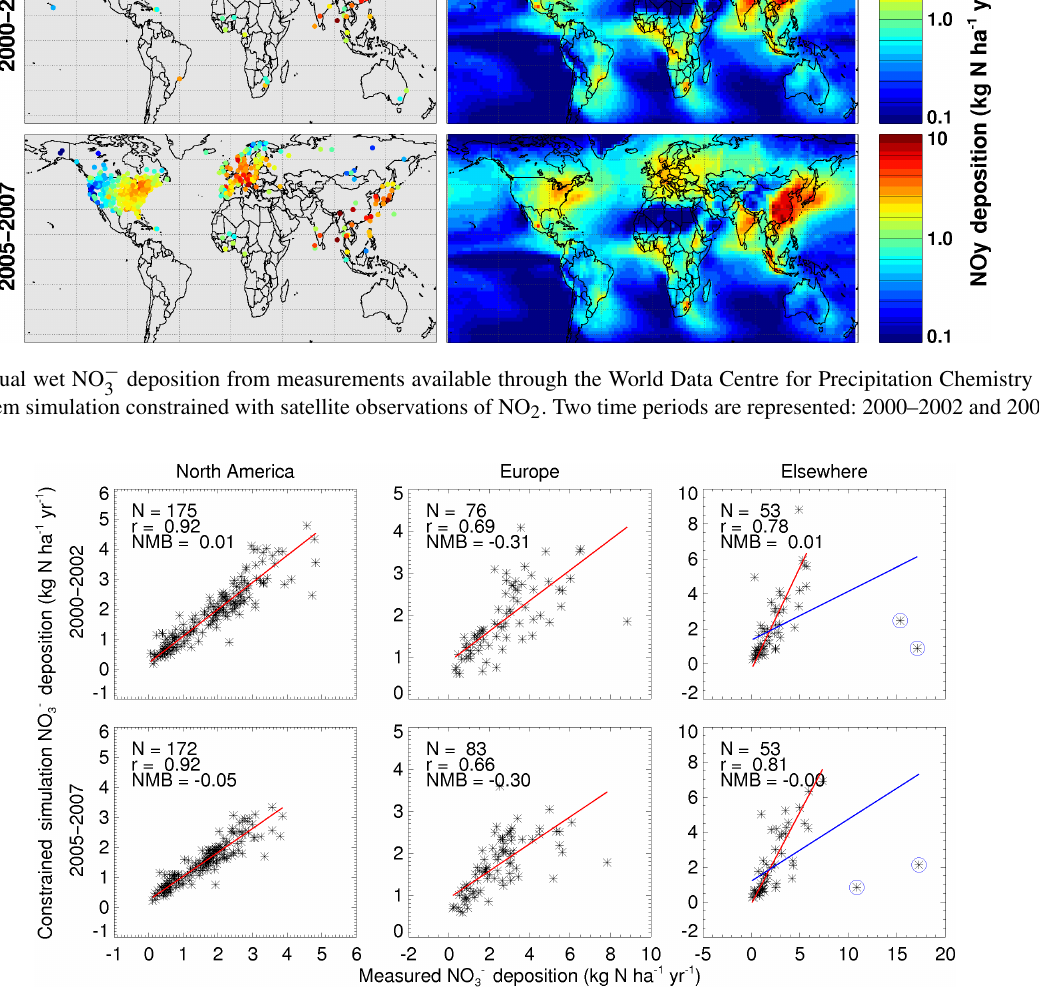
Figure 3. Scatter plot of the satellite-constrained simulated wet NO − deposition vs. measurements available through the World Data Centre 3 for Precipitation Chemistry for specific subsets of the data. The red lines show the result of a reduced major axis linear regression. In the right column, the blue line shows the fit across all data and the red line shows the fit excluding the two circled data points that are discussed in the text (reported statistics refer to the red line